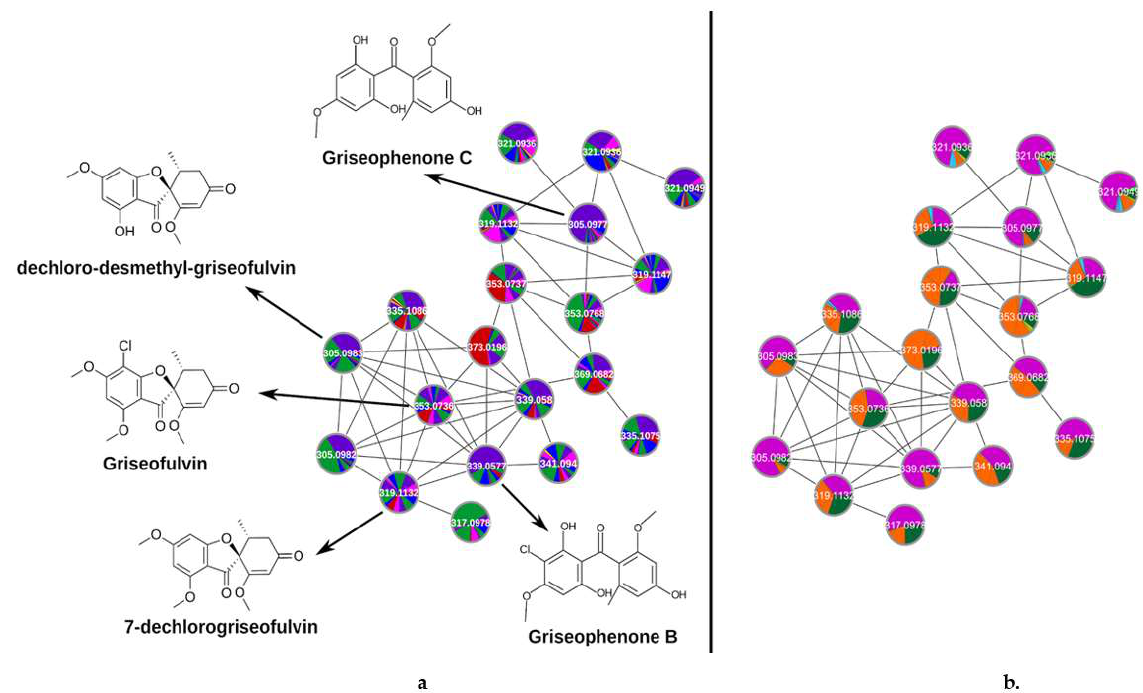
Figure 2. Example of clusters from the molecular network of the identified griseofulvin derivatives and of putatively new unknown metabolites. ( a ) Griseofulvin cluster with color codes discriminate nodes occurring in the extracts obtained from different culture media: blue: rice (R); green: Wickerham modified broth medium (WKM); pink: Czapek broth (CZK); purple: malt extract peptone broth (MEP): red: potato dextrose agar (PDA); and yellow: potato dextrose broth (PDB). The size of a slice is proportional to the relative abundance of a compound. Slices with the same color indicate the production of the compound by more than one strain in the referred culture medium. ( b ) Griseofulvin cluster with color codes discriminate nodes from different strains: dark pink: MPO611 strain ( Phomopsis sp.); orange: MPO620 strain ( Hypoxylon sp.); and dark green: MPO658 strain ( Aspergillus sp.). Comparing both charts, it is possible to overlap the slices and find the best strain-culture medium combination by color coding for a specific node.